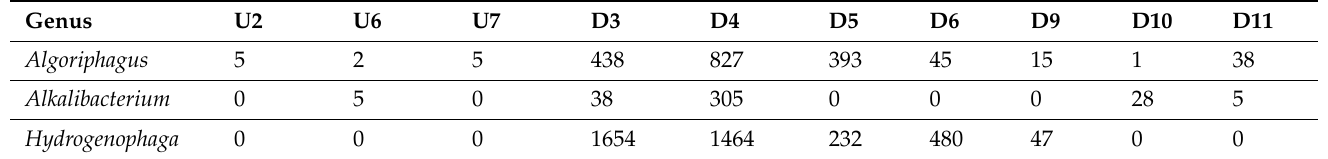
Table 12. Greatest bacterial abundance by genus for the Zone F downstream sites (D5, D6, D9, D10, D11). These sample sites were dominated by mesophilic species. Importantly, they were relatively absent from the acidic